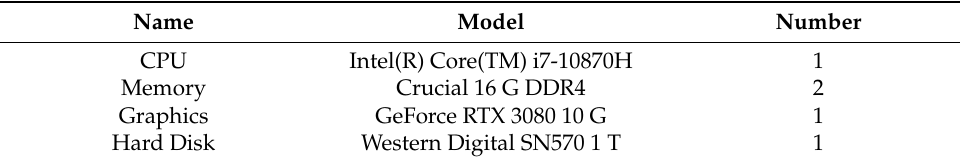
Table 3. Experimental environment